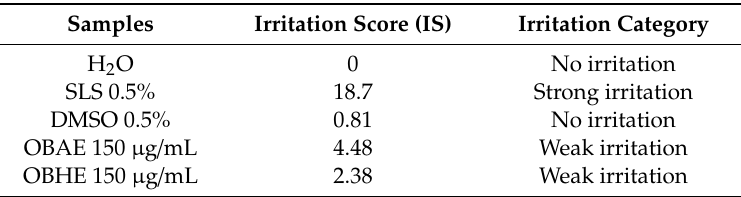
Figure 4. Irritability evaluation using the HET-CAM assay for basil hydro-alcoholic extracts (OBAE and OBHE, in concentration of 150 μg/mL) and control samples (water, SLS and DMSO 0.5%); images represent the CAM area of administration before sample application ( t 0 ) and five minutes after application ( t 5 ), by stereomicroscopy, magnification × 2. Table 4. Irritation score induced by basil extracts. Values corresponding to the irritation score next to the irritation category are shown for the two basil extracts (OBEA and OBHE), positive (SLS 0.5%), negative (H 2 O) and solvent control (DMSO